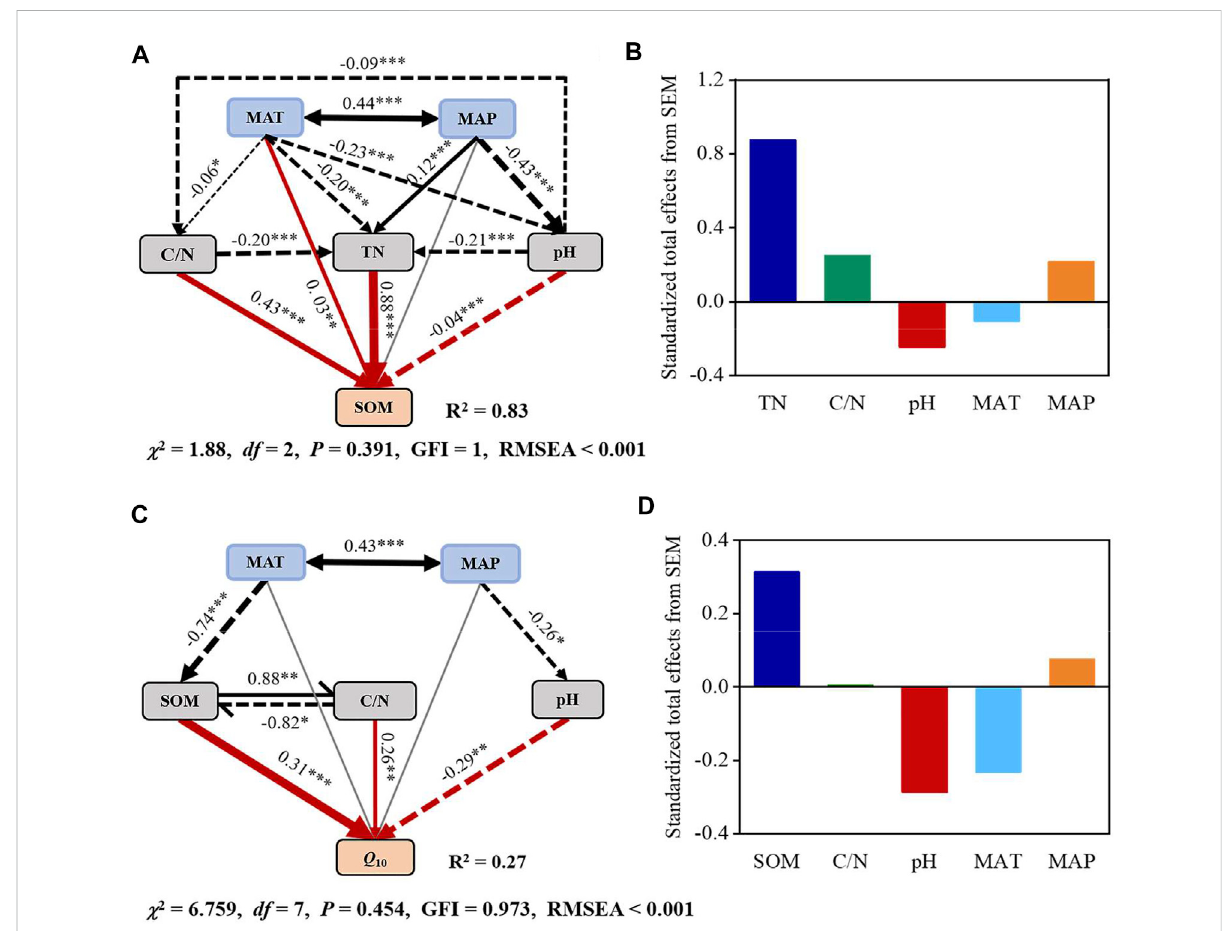
FIGURE 6 Structural equation model (SEM) on the direct and indirect effects of SOM (A) and Q 10 (C) and standardized total effect (direct plus indirect effects)derivedfromSEM (B,D) onaglobalscale.Solidanddashedlinesindicatepositiveandnegativeeffects,respectively;thegraylineindicatesthat the relationship is not signi fi cant at the 0.05 level; line thickness represents the magnitude of the path coef fi cient. The numbers adjacent to arrows are standardized path coef fi cients, indicating the effect size of the relationship. MAT, mean annual temperature; MAP, mean annual precipitation;SOM,soilorganiccarbon;TN,totalnitrogen;C/N,ratioofcarbonandnitrogen.Goodness-of- fi tstatisticsareshowninthemodel.* p < 0.05, ** p < 0.01, and *** p <